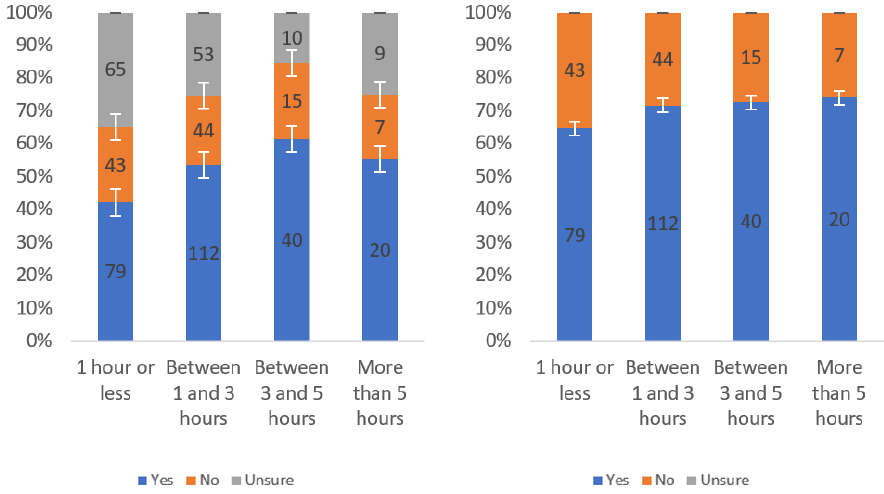
Figure 34. Responses regarding others’ willingness to review by internet usage level including ( left ) and excluding ( right ) unsure